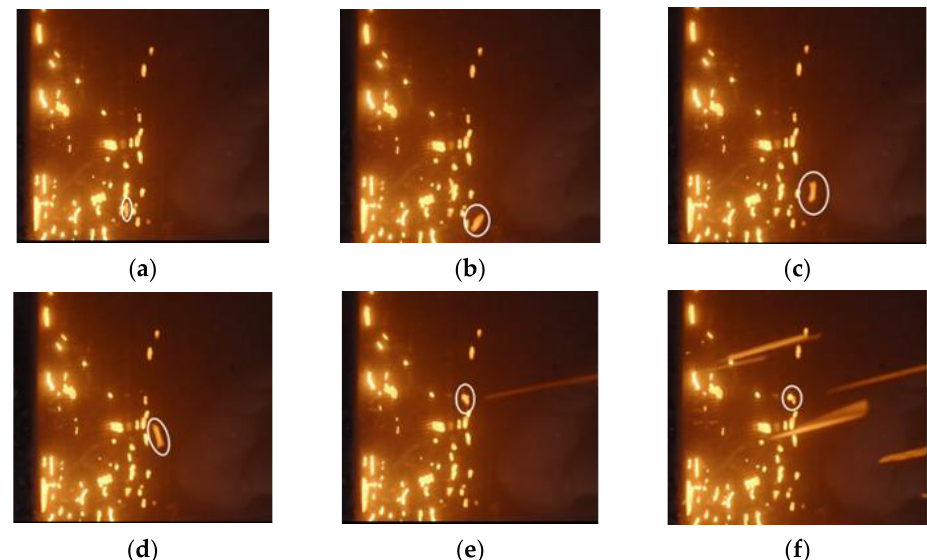
Figure 13. Firebrands bounce back after hitting the mesh. The encircled firebrands ( a ) impact the mesh, ( b ) bounce back, ( c – e ) return to the mesh and ( f ) settle into a new position and continue to burn (Stainless Steel Wire and Mesh Pty Ltd. [17]).